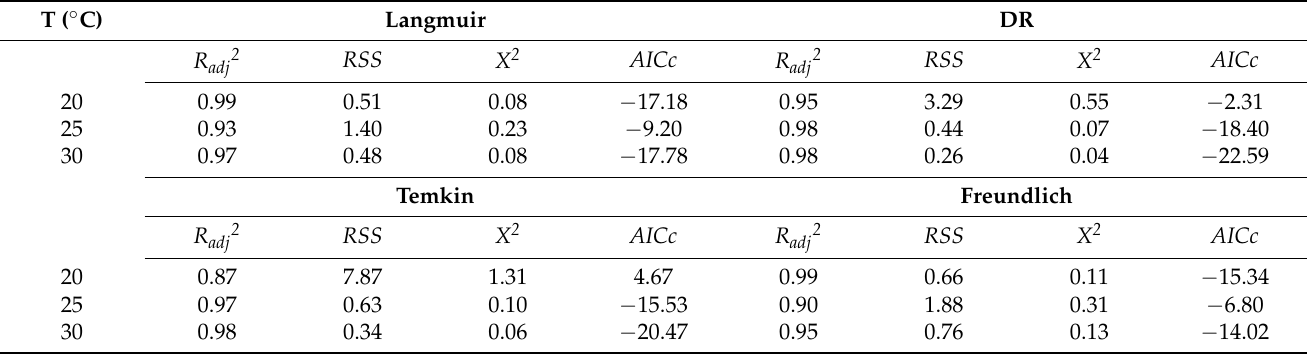
Table 6. Statistical analysis of adsorption isotherm models at different